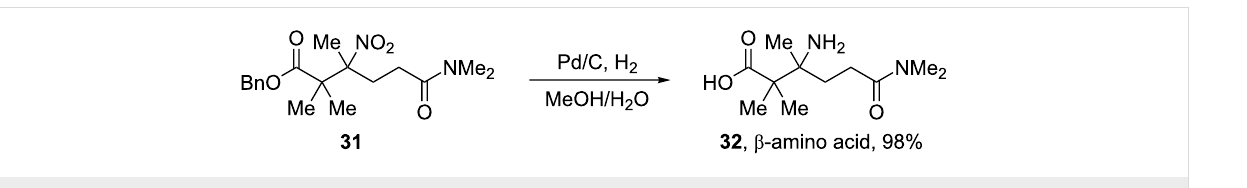
Scheme 7: Synthesis of highly congested β -amino